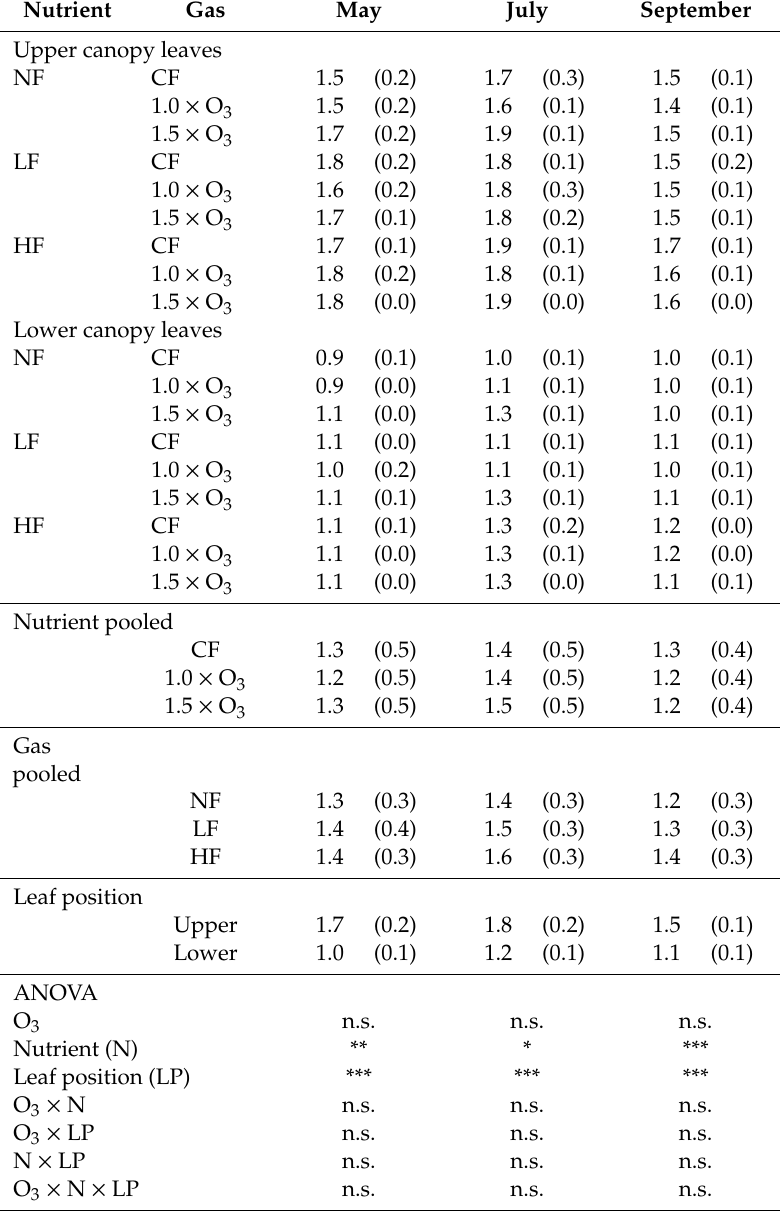
Table 4. Area-based nitrogen content (g m − 2 ) in upper and lower canopy leaves of Siebold’s beech